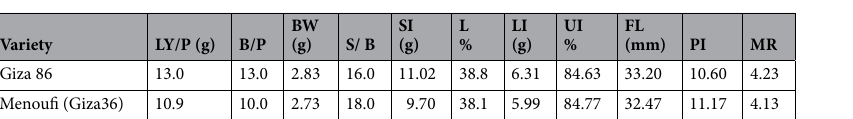
Table 8. Characteristics of the cotton parental genotypes under this study. LY/P = Lint yield/plant, B/P = Bolls/ plant, BW = Boll weight, (S/B) = Seeds/boll, SI = Seed index, L % = Lint percentage, LI = Lint index, FL = Fiber length, UI = Uniformity index, PI = Pressley index and MR = Micronaire reading.